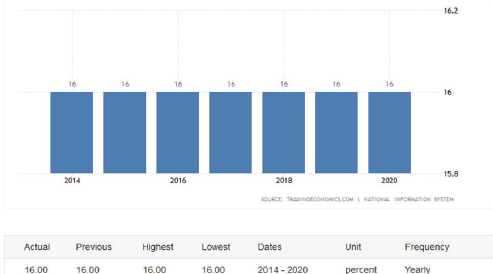
Fig. 1. the rates of Value Added Taxes (VAT) by year in Jordan Source: (Economics,